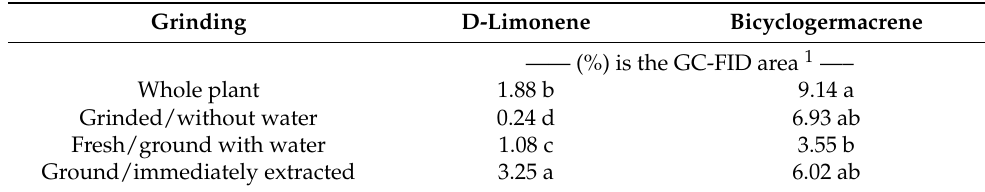
Table 3. Mean concentration (%) of D-limonene and bicyclogermacrene obtained from the four levels of Grinding where the effect of Grinding is